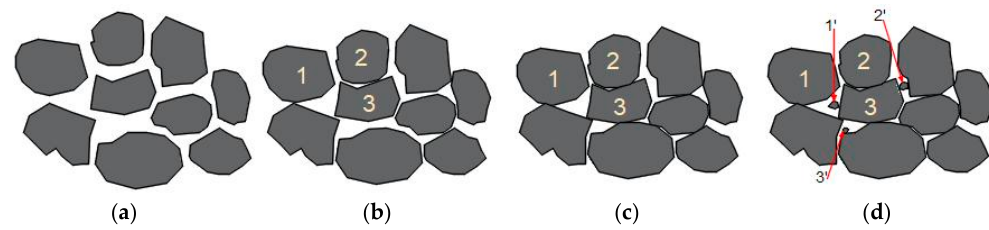
Figure 4. Compaction stages and possible breakdown: ( a ) initial placement; ( b ) initial compaction; ( c ) well-consolidated ballast; ( d ) breakdown with subsequent compaction [5].